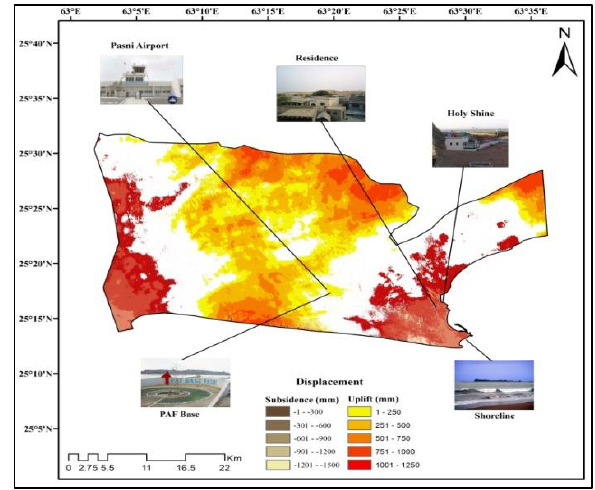
Figure 4. Map showing the major affected areas due to vertical displacement caused by the earthquake in Pasni, Balochistan .